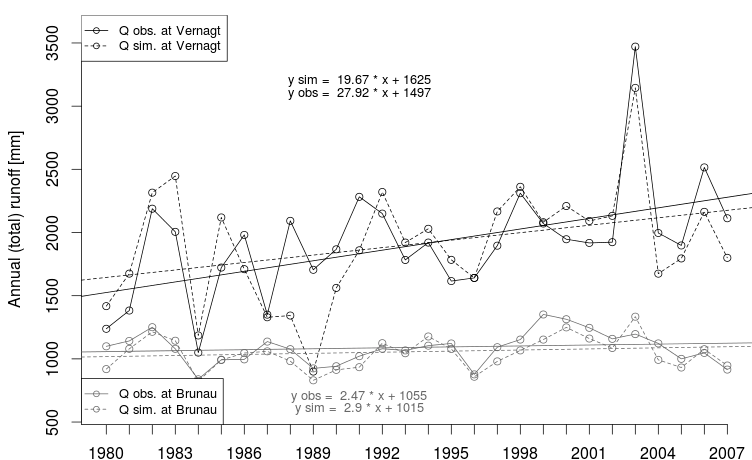
Figure 6. Simulated and observed annual streamflow (Q) for Vernagtbach and Brunau gauging stations during the calibration period and linear trends (y obs/sim = observed/simulated runoff; x = year—1979).